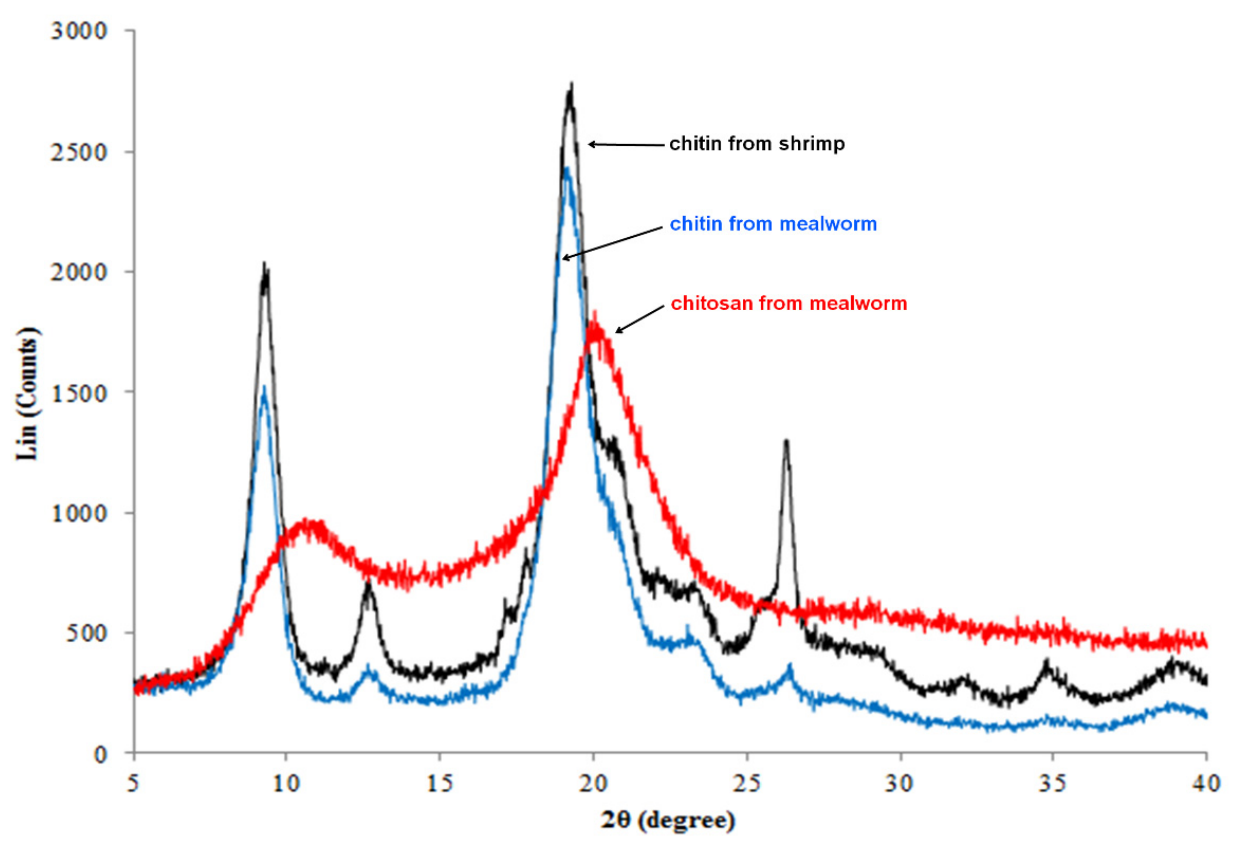
Figure 4. X-ray diffraction (XRD) data of chitin and chitosan. Table 4. Degree of crystallinity of extracted chitin from mealworm or shrimp. Mealworm Chitin Shrimp Chitin Degree of crystallinity